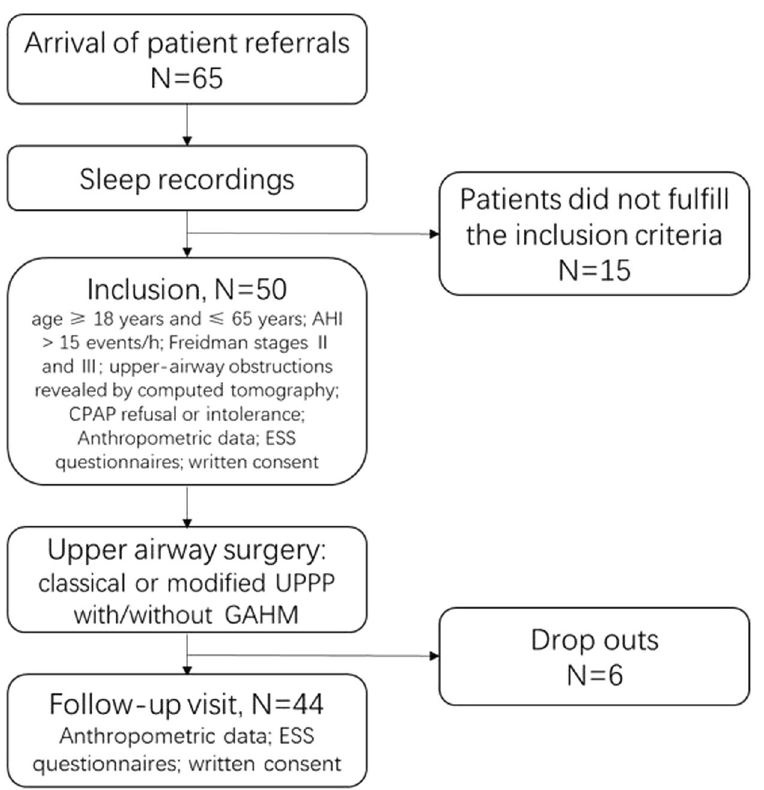
Figure 1. Flow chart of recruiting participants in our